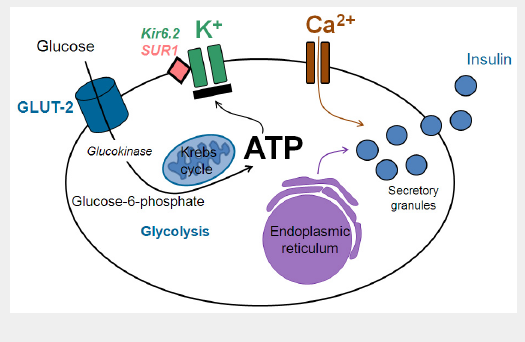
Figure 2 Location of the gene mutations and affected proteins in the pancreatic beta cell in monogenic diabetes mellitus. MODY (red), mitochondrial diabetes (blue) and neonatal diabetes